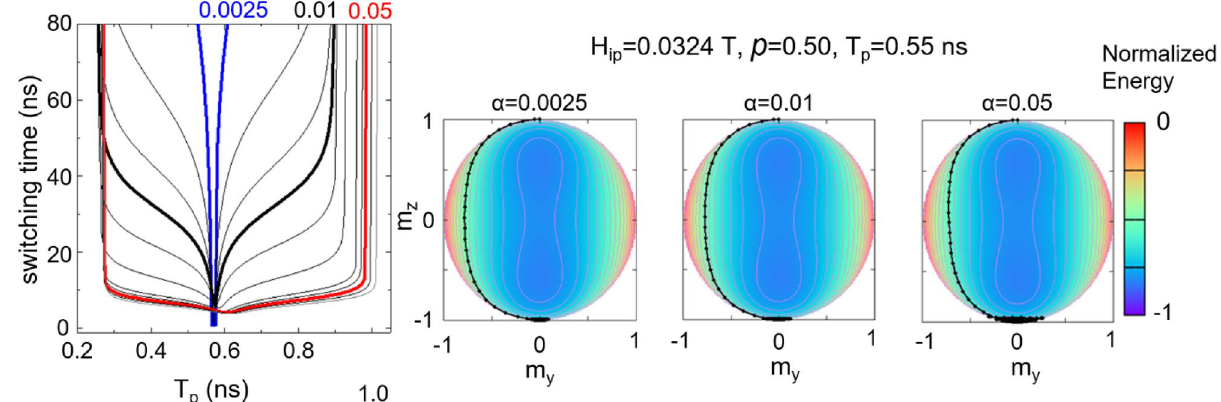
Figure 5. Slice through the first resonant switching line, for α = 0.0025, 0.01 and 0.05, H ip = 0.0324 T and 50% modulation in anisotropy. Corresponding magnetization trajectories for different α values are represented on a normalized energy